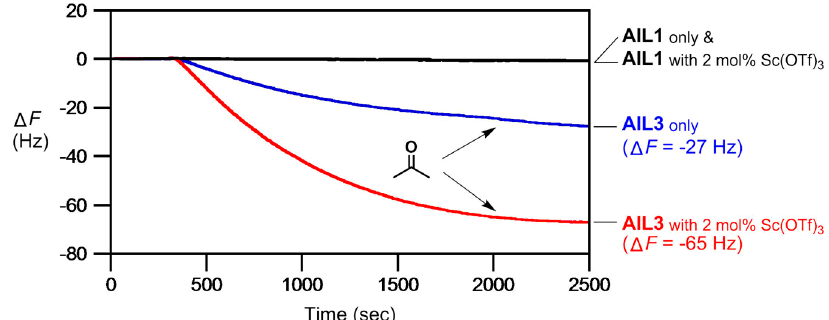
Figure 9. An ultrasensitive, 2 mol% Sc(OTf) 3 -catalyzed detection of acetone gas (58 ppb) by 9 MHz QCM thin-coated with AIL3 (3.3 nL each, 300 nm thickness). AIL1 was used here as the control ionic liquid. Gaseous acetone sample was injected at 300 s.